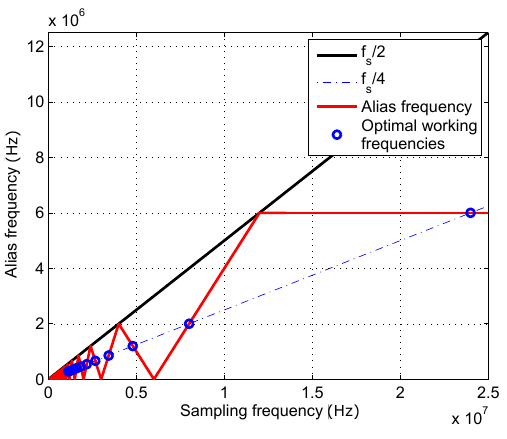
(cid:16) (cid:17) f (cid:48) as a function of sampling frequency ( f s ) . Optimal M